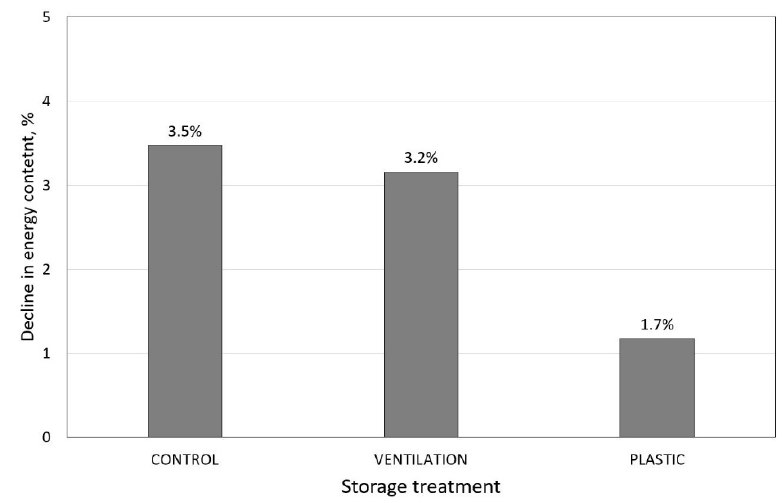
Figure 6. Estimated average energy losses during the experiment (%) by storage